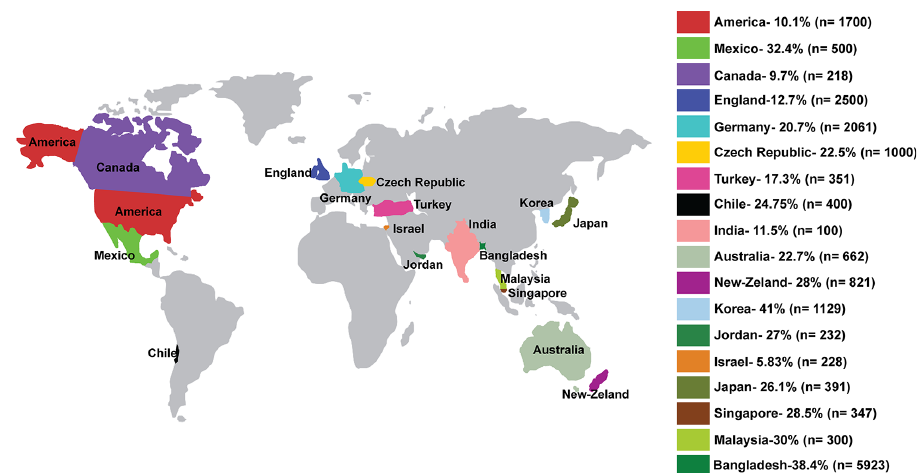
Fig 3. Global distribution of prevalence of third molar